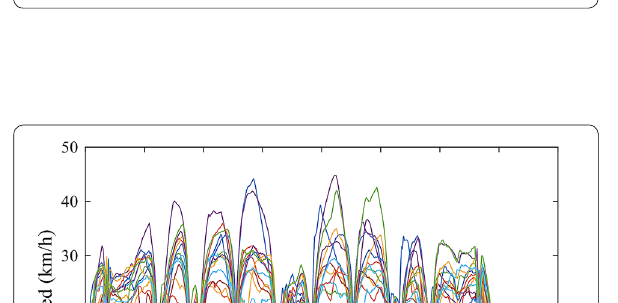
Figure 2 Driving speeds under the fixed route